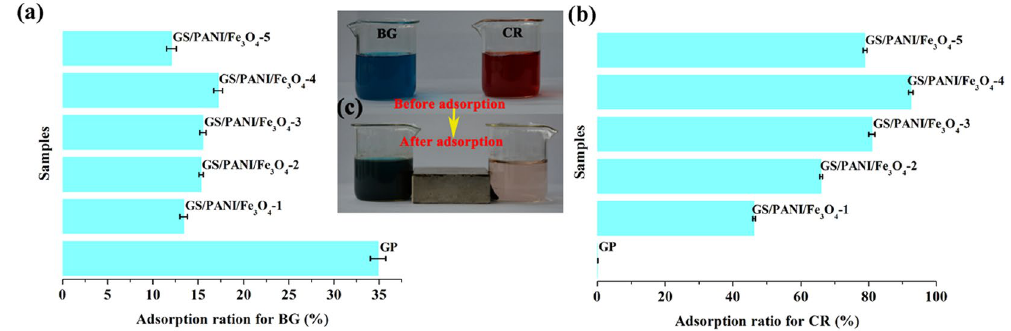
Figure 7. Adsorption ratio of the nanocomposites toward different dye solutions ( a ) 100 ppm of BG, ( b ) 100 ppm of CR. ( c ) Digital photographs of 100 mg/L of BG and CR solution before and after adsorption using GS/ PANI/Fe 3 O 4 -4 as adsorbent.